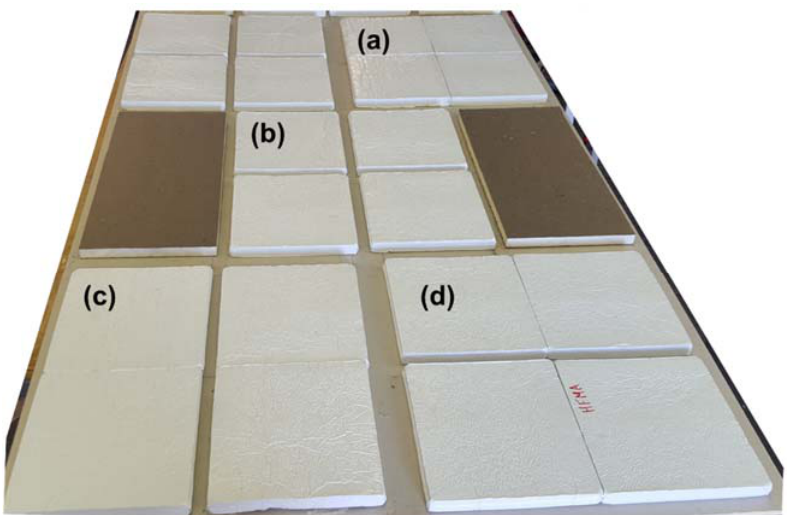
Figure 1. VIP (vacuum insulation panel)-HD (high-density) board composite for 0.61 m × 0.61 m samples. Samples ‘a’–‘d’ contain different configurations of VIPs (with and without foam gaps) and were used for testing and evaluation. ( a ) all VIPs butt-jointed; ( b ) foam gaps between all VIPs; ( c ) VIPs butt-jointed along the length and with a foam gap along the width; ( d ) VIPs butt-jointed along the width and with a foam gap along the length.